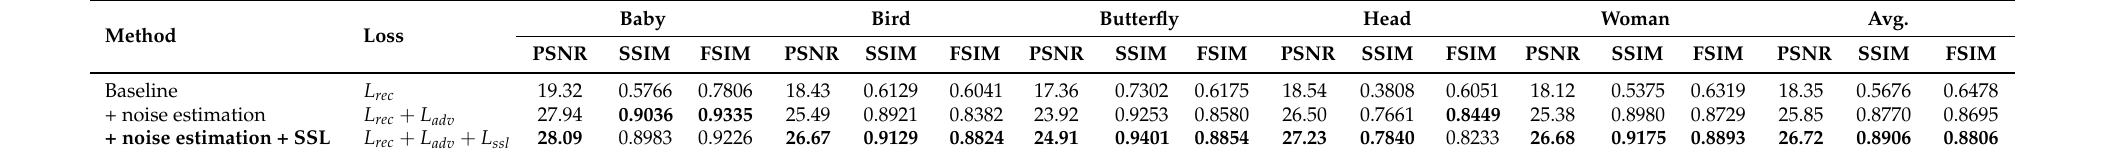
Table 3. Ablation study on the Set5 [11] dataset ( s = 2, σ = 25). The best results are highlighted in